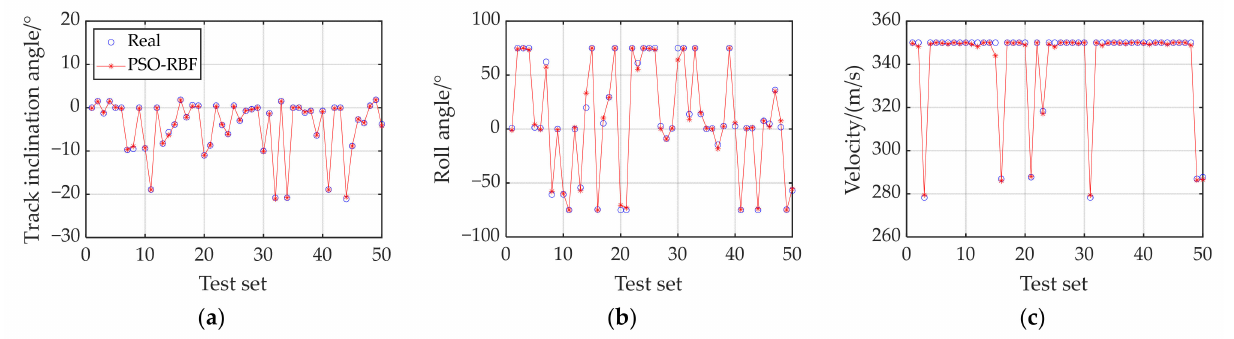
Figure 5. The output results of the test set: ( a ) track inclination angle command, ( b ) roll angle command, and ( c ) velocity angle command.